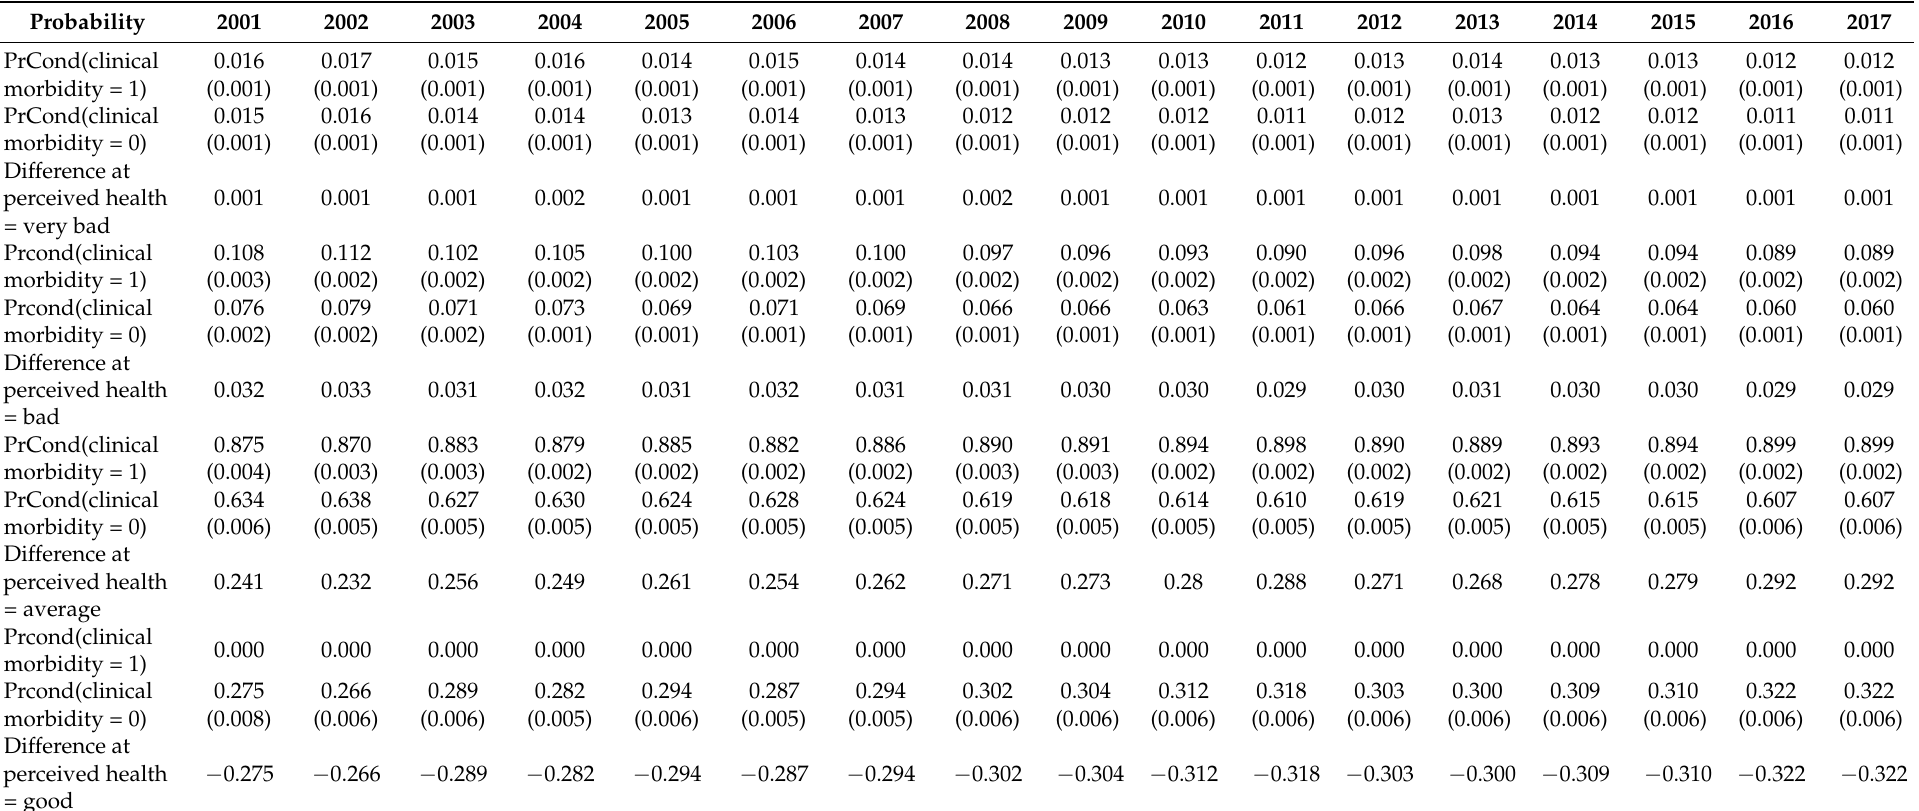
Table 4. Conditional probabilities and difference in conditional probabilities for different levels of perceived